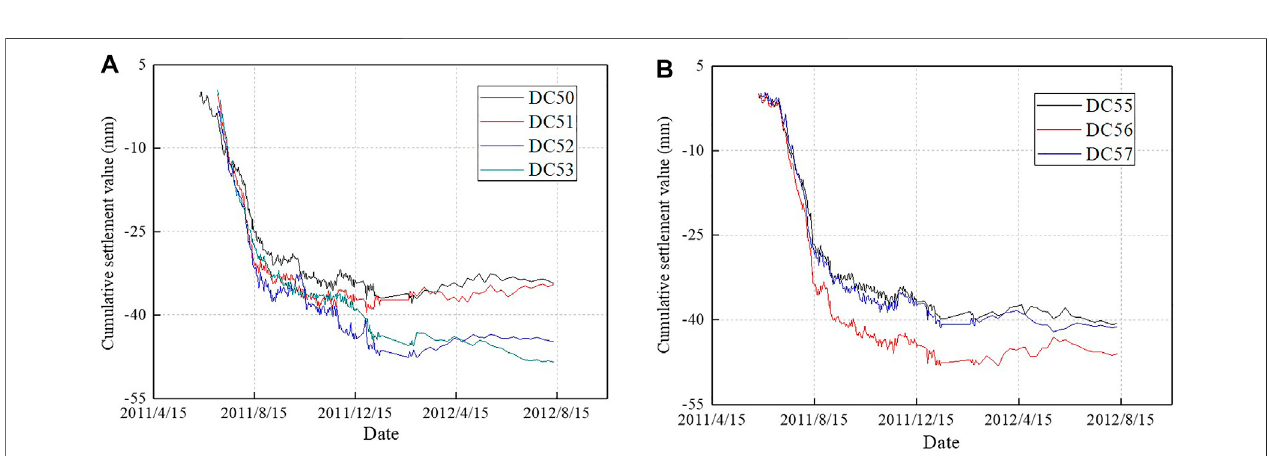
FIGURE 6 | Settlement change curve of Fushansuo Road Station. (A) DC50 ～ DC53; (B) DC55 ～ DC57.